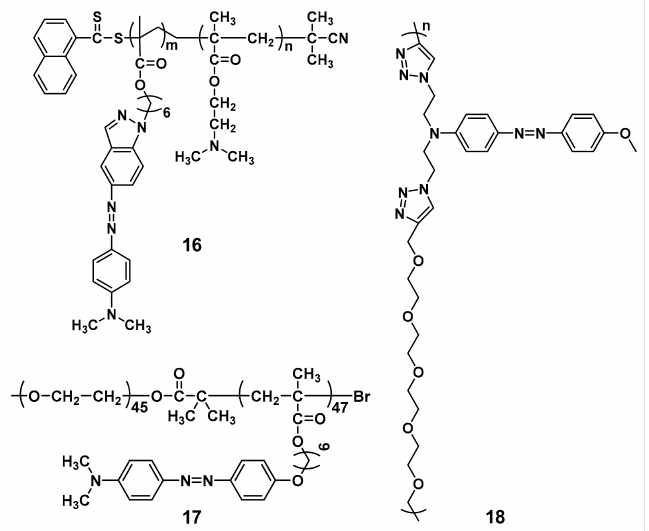
Figure 12. The molecular structure of azobenzene-containing polymers 16 , 17 and 18 with AIE